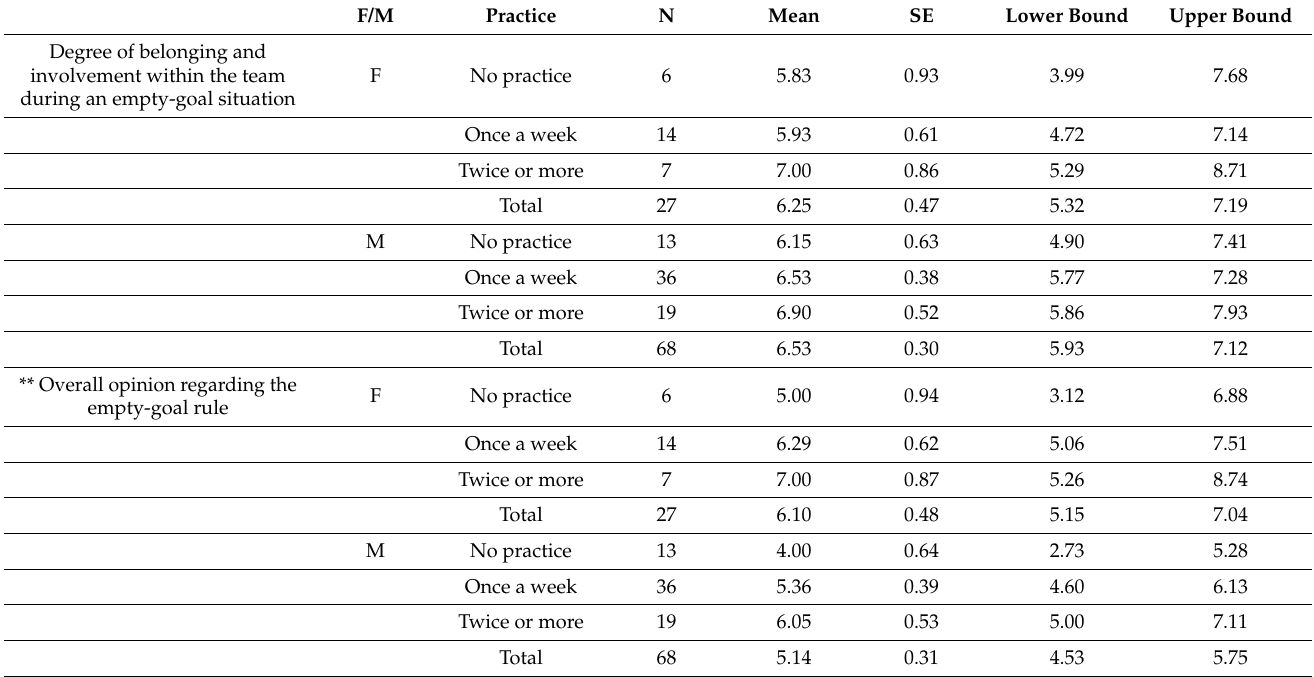
Table 5. Means and 95% confidence intervals for the female and male goalkeepers’ sense of belonging and overall opinion divided by the amount of practice of empty-goal scenarios.